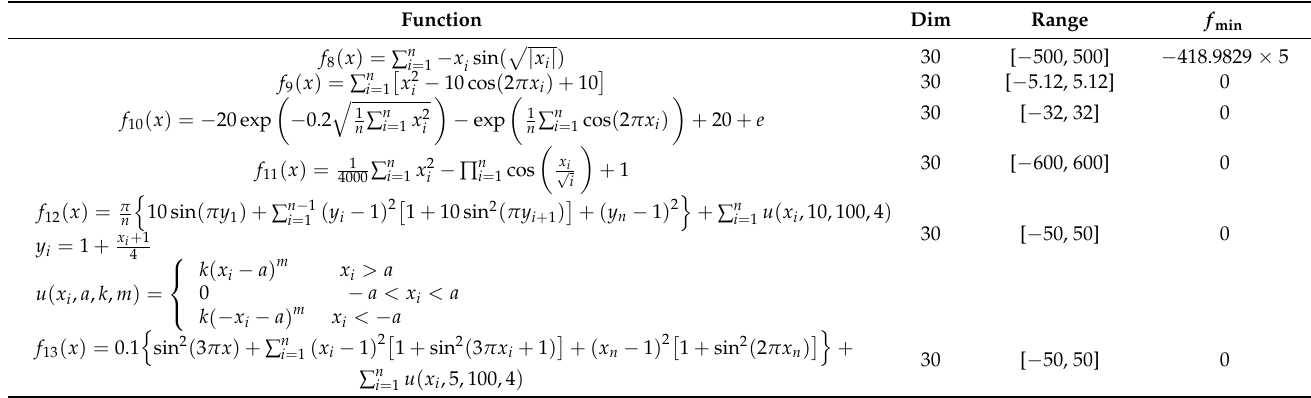
Table 2. Description of multimodal benchmark functions.